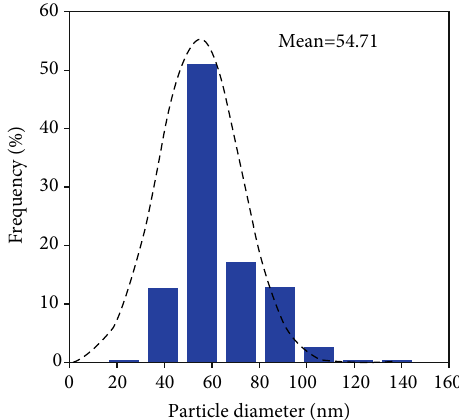
Figure 3: The particle size distribution for melatonin-loaded nanoparticles (MTNPs).